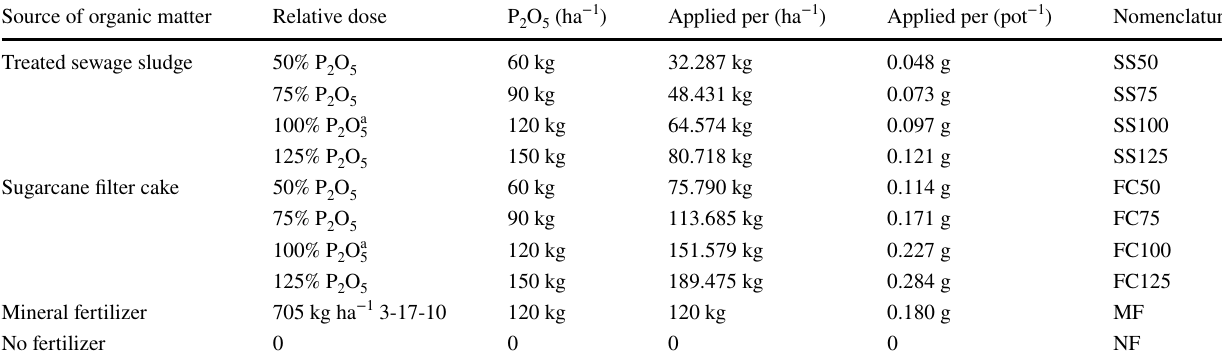
a For the calculation of fertilization levels of 50, 75, 100 and 125% of the P ity of Minas Gerais State (CFSEMG 1999)